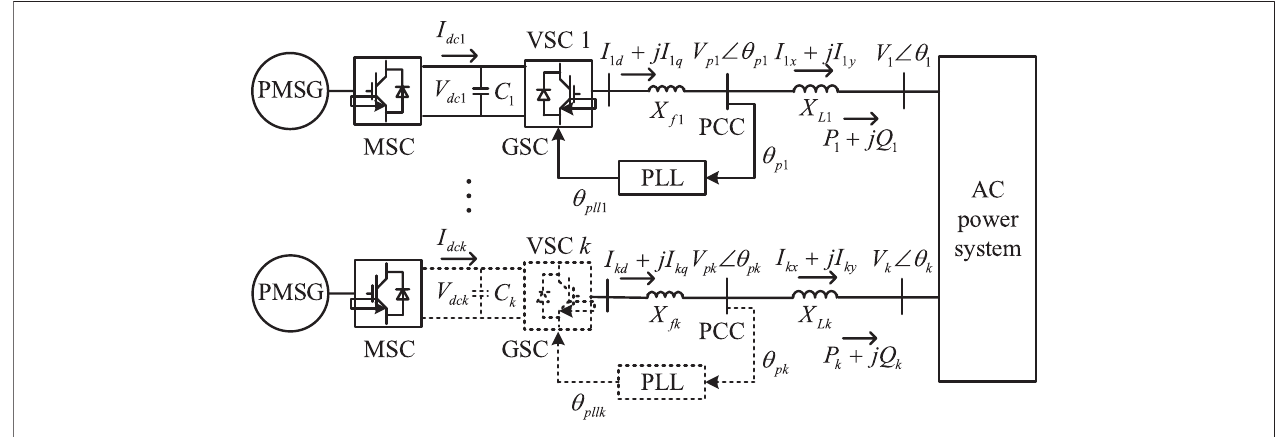
FIGURE 1 | Con fi guration of power system with multiple integrated PMSGs (MSC: machine-side converter; GSC: grid-side